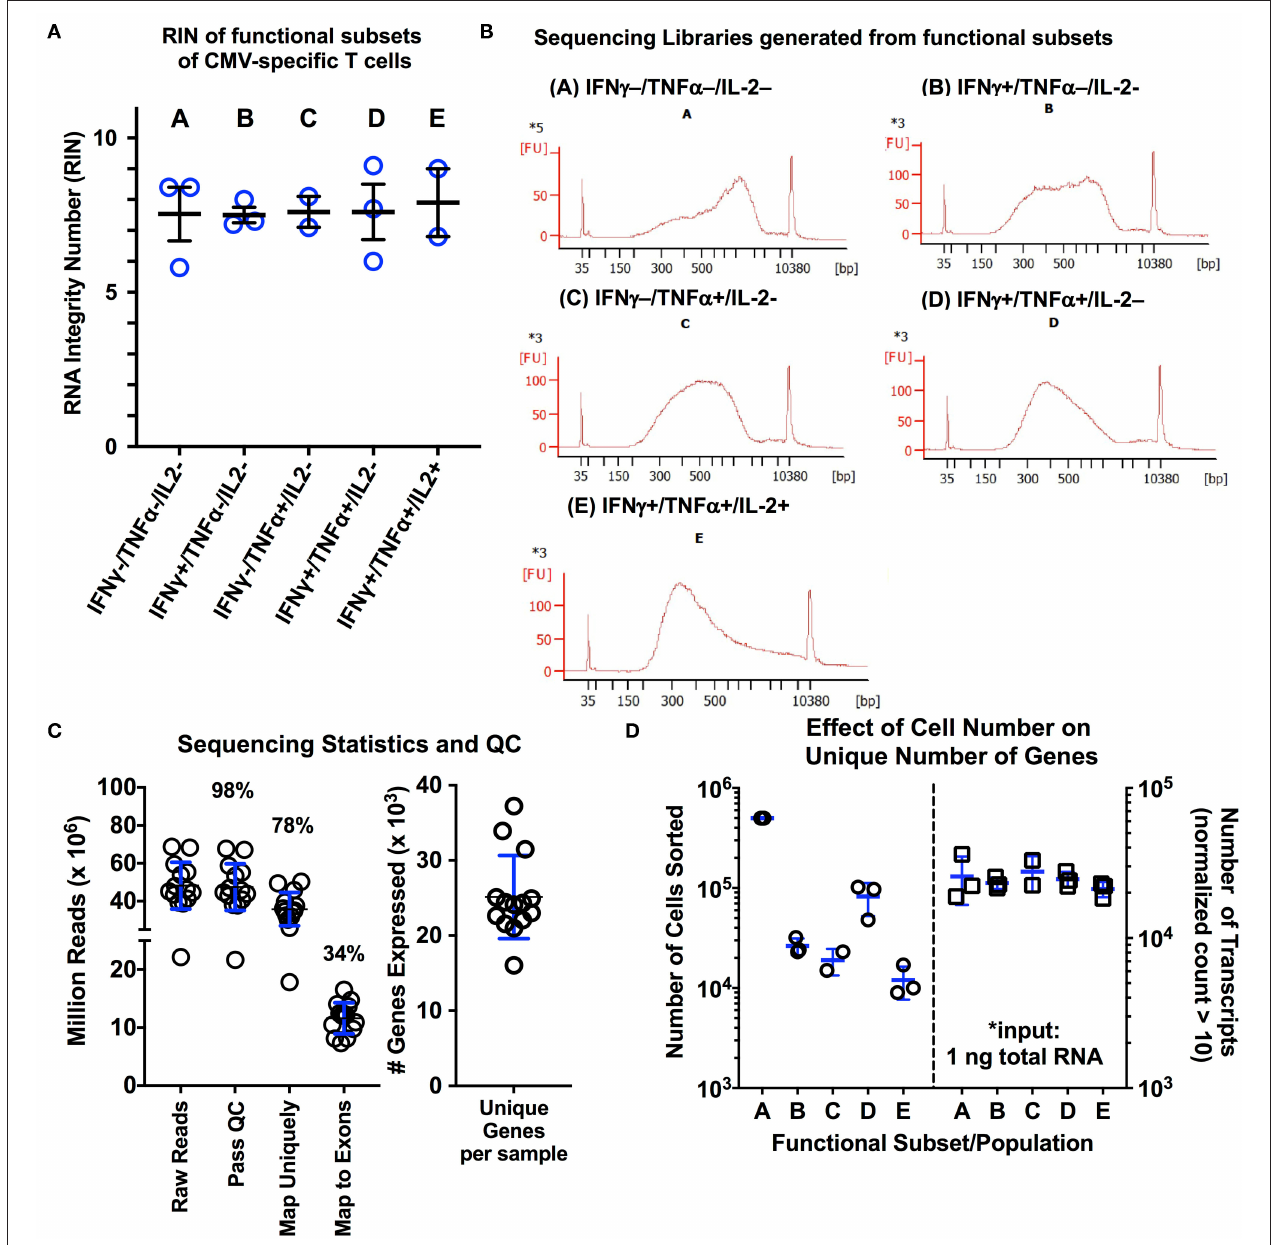
FIGURE 2 | (A,B) RNA quality measurements and representative cDNA libraries for functional subsets CMV-specific CD8 + T cells isolated using the modified protocol. Following activation with a CMV peptide pool, cells were processed and stained using the modified protocol, and the five predominant functional subsets of CMV-specific CD8 + T cells were sorted. Following RNA isolation using the Ambion FFPE Recoverall kit, RIN values were obtained for three different donors ( n = 3 subjects; blue lines on graph represent mean ± SD). Of the 15 individual RNA samples, two of the RNA electropherograms were unable to be fitted by the RIN algorithm due to the low overall RNA input. The average RIN value of the remaining 13 libraries was 7.60 ± 1.03. (B) Representative cDNA libraries generated using the Clontech PICO input stranded total RNA kit are shown. (C) Sequencing statistics and quality control analysis results for the 15 libraries following sequencing on the Illumina HiSeq4000 platform (2 x 150 bp; 20% PhiX spike-in; 5 samples per lane). The average number of unique transcripts detected was 25.127 ± 5.53 (x10 3 ) per sample (blue lines on graph represent mean ± SD). (D) Examination of the effect of the number of sorted cells on number of unique transcripts, as a measure of RNA complexity ( n = 3; blue lines on graph represent mean ± SD). A total of 1 ng of total RNA was used for library generation for each population, independent of the number of cells collected during sorting. Overall, we observed no significant effect of cell number isolated during sorting on the number of unique transcripts. Statistical testing: * p < 0.05. Populations: (A) non-functional (IFN γ -/TNF α -/IL-2-); (B) IFN γ only/monofunctional (IFN γ + /TNF α -/IL-2-); (C) TNF α monofunctional (IFN γ -/TNF α + /IL-2-); (D) bifunctional (IFN γ + /TNF α + /IL-2-); and (E) polyfunctional (IFN γ + /TNF α + /IL-2 + ).